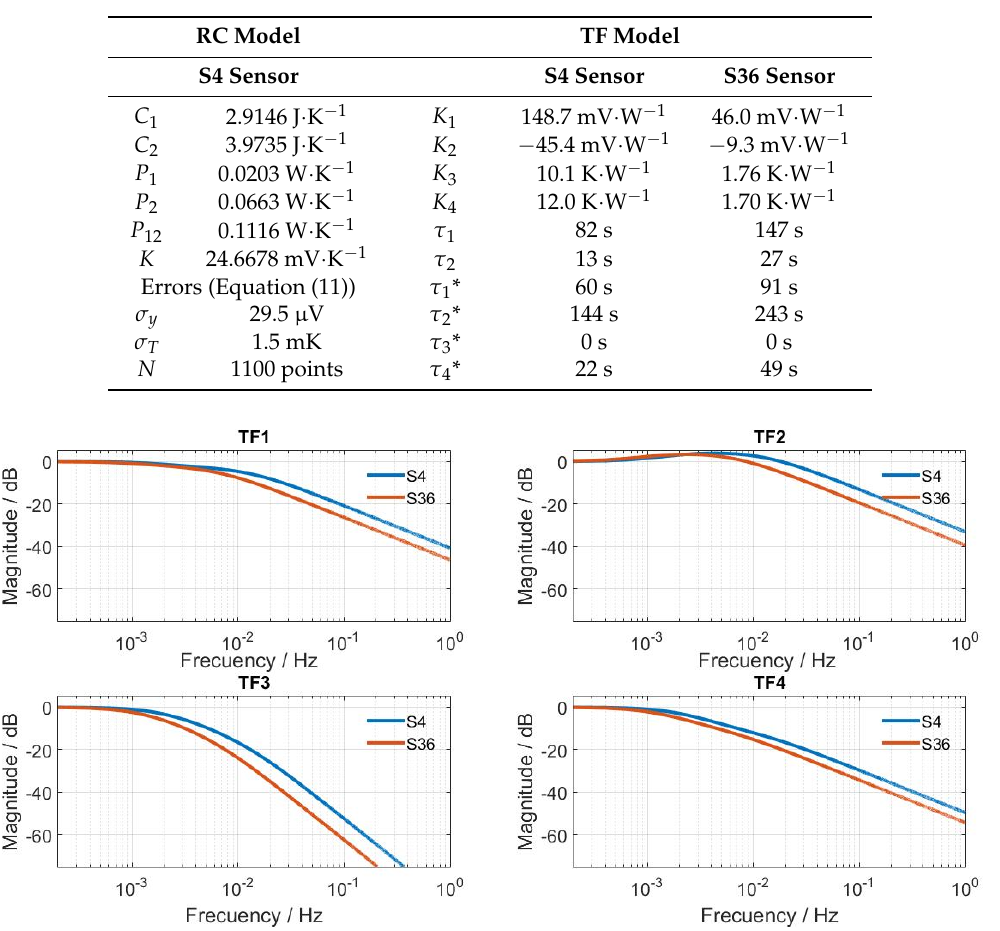
Figure 8. Log-magnitude curves for the transfer function given by Equations (4) and (5). S4, 4 cm 2 minisensor described in this study. S36, an earlier 36 cm 2 sensor (Reference [5]).